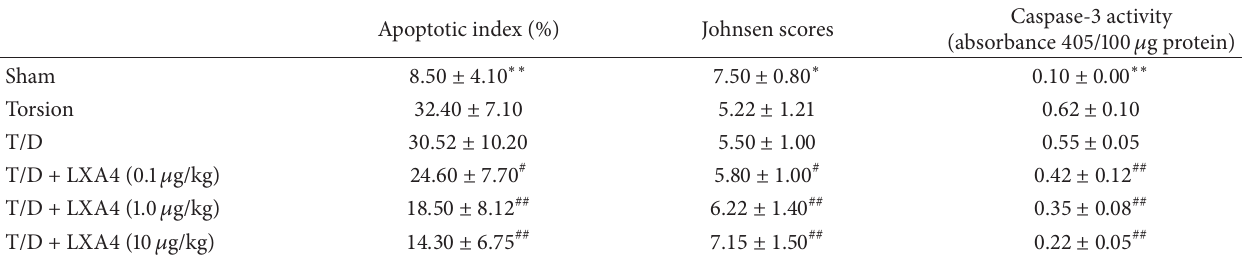
Figure 6: Electron microscopy of testicular tissue in different groups ( × 2000), N: nuclei, and M: mitochondria. (a) Sham group: normal testicular structure was seen in sham group. (b) Torsion group and (c) torsion/detorsion (T/D) group: swollen mitochondria with degenerated cristae and enlarged intercellular spaces were observed under electron microscopy. (d), (e), and (f): T/D + LXA4 subgroup 1–3, respectively: LXA4 pretreatment was effective in preventing mitochondria degeneration and dilation of intracellular spaces. Table 1: Apoptotic index, Johnsen scores, and caspase-3 activities in different groups (mean ±